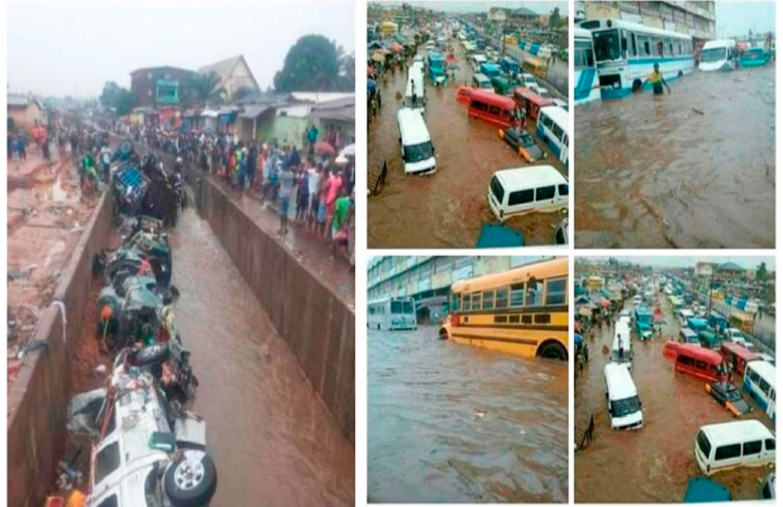
Figure 2. Pictures of flood occurrence in